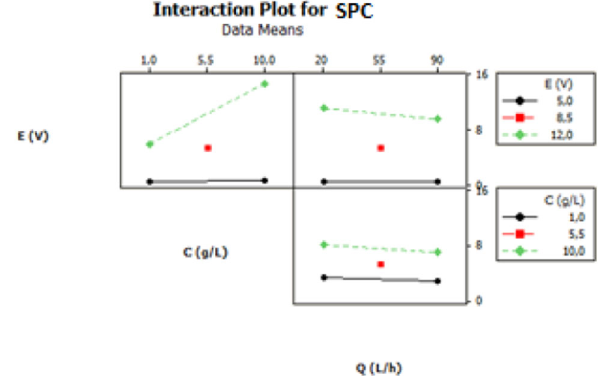
Fig. 7 Interaction effects plot for